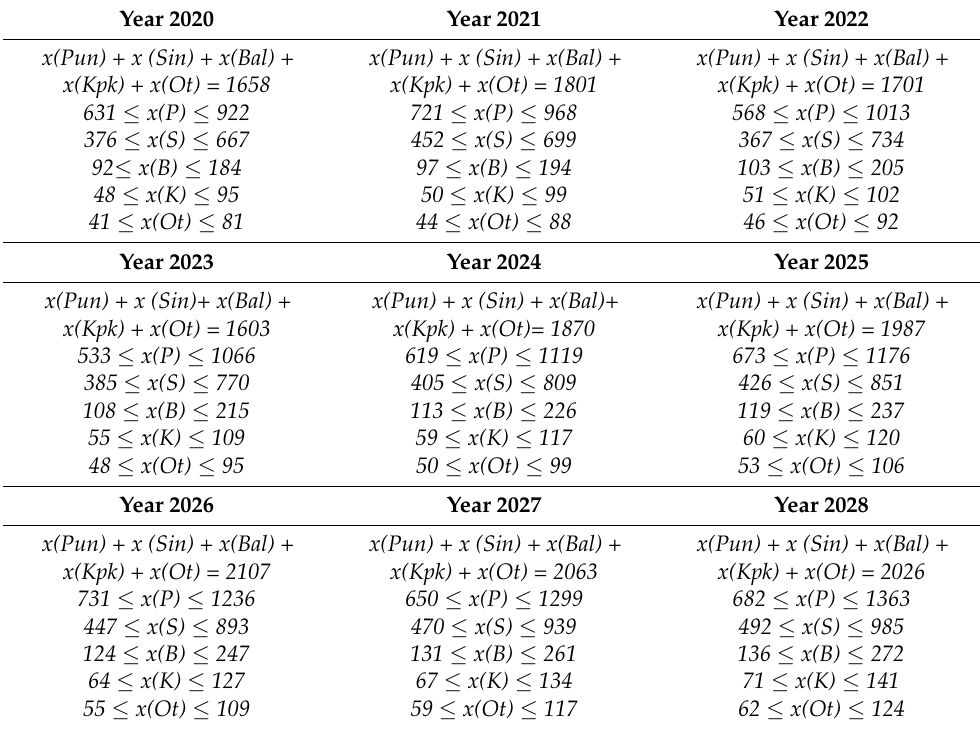
Table 3. Gas-Allocation Core Solutions Scenarios (BCF/y with respect to available natural-gas resources).